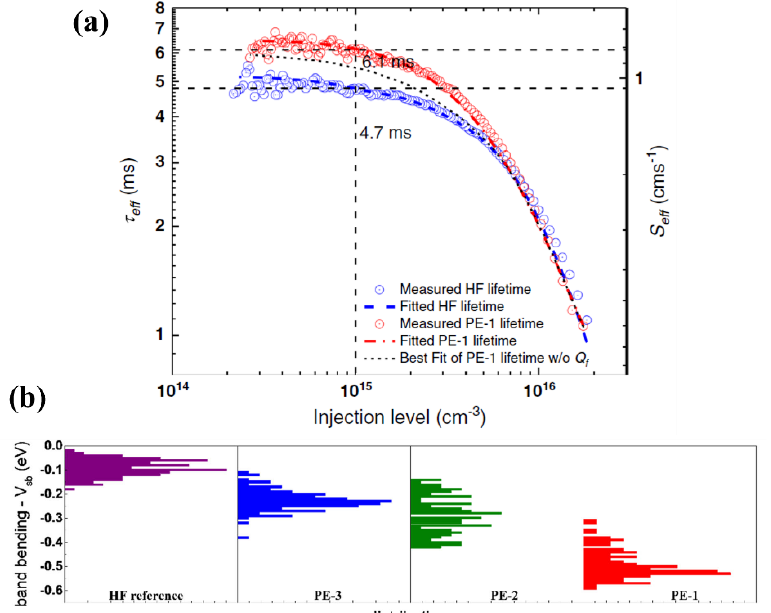
Figure 10. ( a ) The τ eff and the corresponding effective surface recombination rate (S eff ) of HF and PE − 1 samples as a function of injection level. ( b ) The band bending of the HF and PE samples [138]. The difference between the PE samples is the hydrogen flow rate and pressure, all other parameters are constant. Table 1. Performance, contact features and cleaning methods of high − efficiency SHJ solar cells. Features